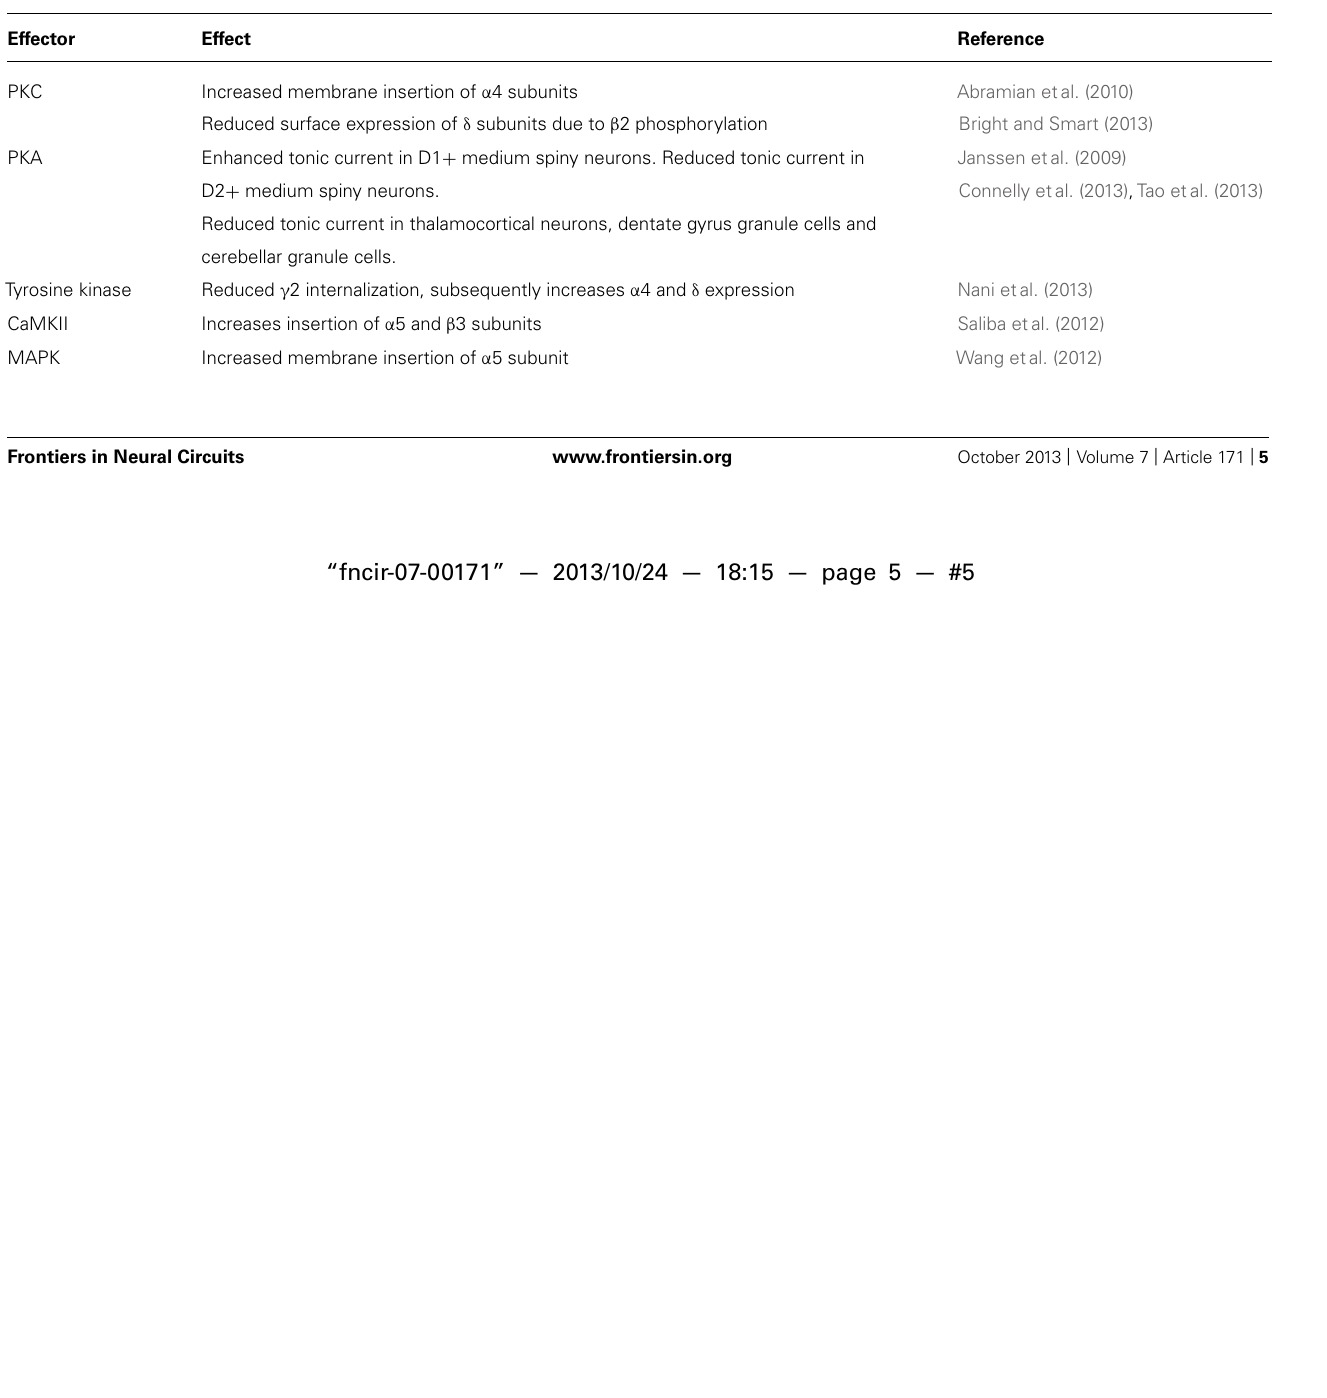
Table 1 | Summary of the effects of kinase action on GABA A receptor mediated tonic